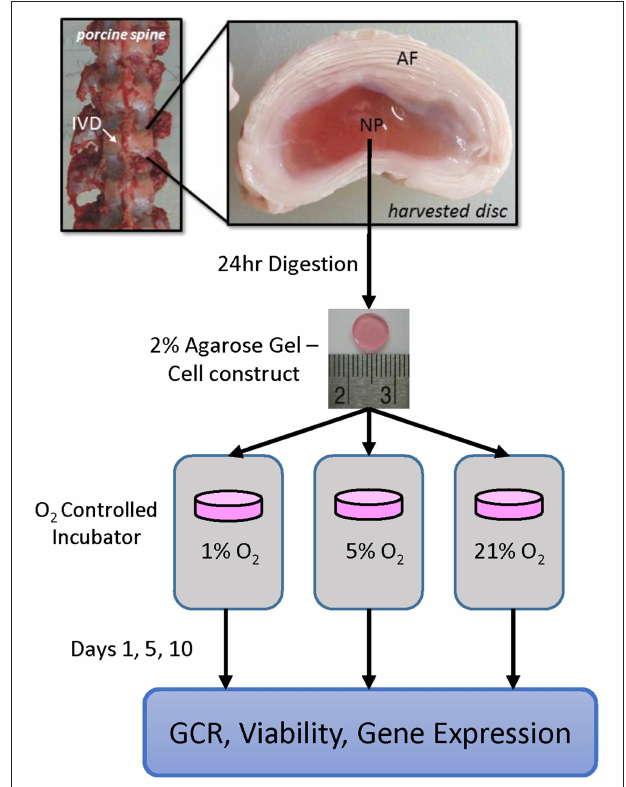
FIGURE 1 | Schematic showing the experimental design, including harvest location and timeline. Annulus fibrous (AF) and nucleus pulposus (NP) regions are shown; cartilaginous endplate (CEP) is located at the interface between the disc and adjacent bony vertebrae (not shown).